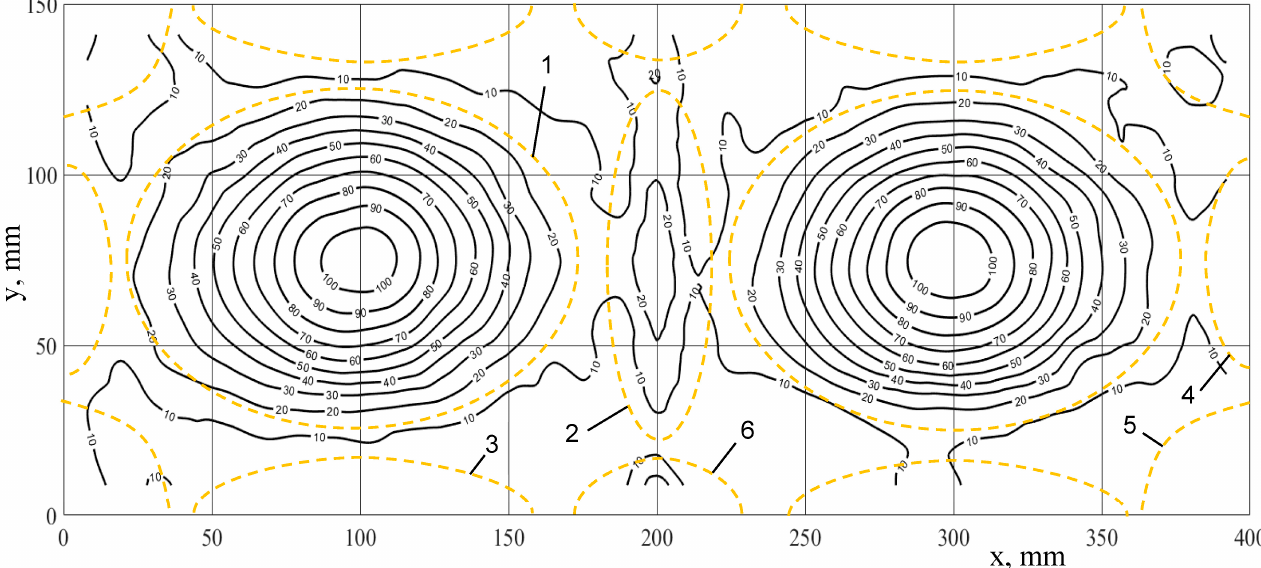
Figure 6. Contour representation of the pressure field generated by the simultaneous explosion of the two wires plotted from the mean test values. The digits on the isobars are in MPa. Contours of the revealed loading zones with: 1—direct shock wave (2 zones); 2—non-linear interaction of direct shock waves; 3, 4, 5, 6—concentration of direct and reflected shock waves along rigid walls (12